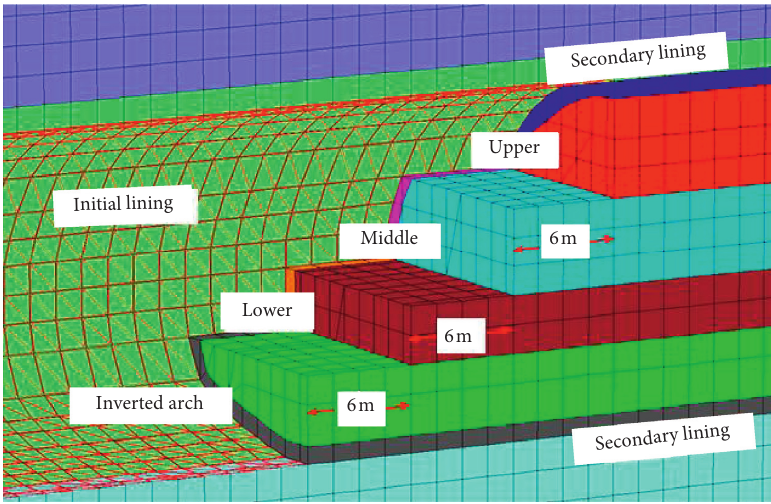
Figure 22: Simulation of three-bench method excavation.